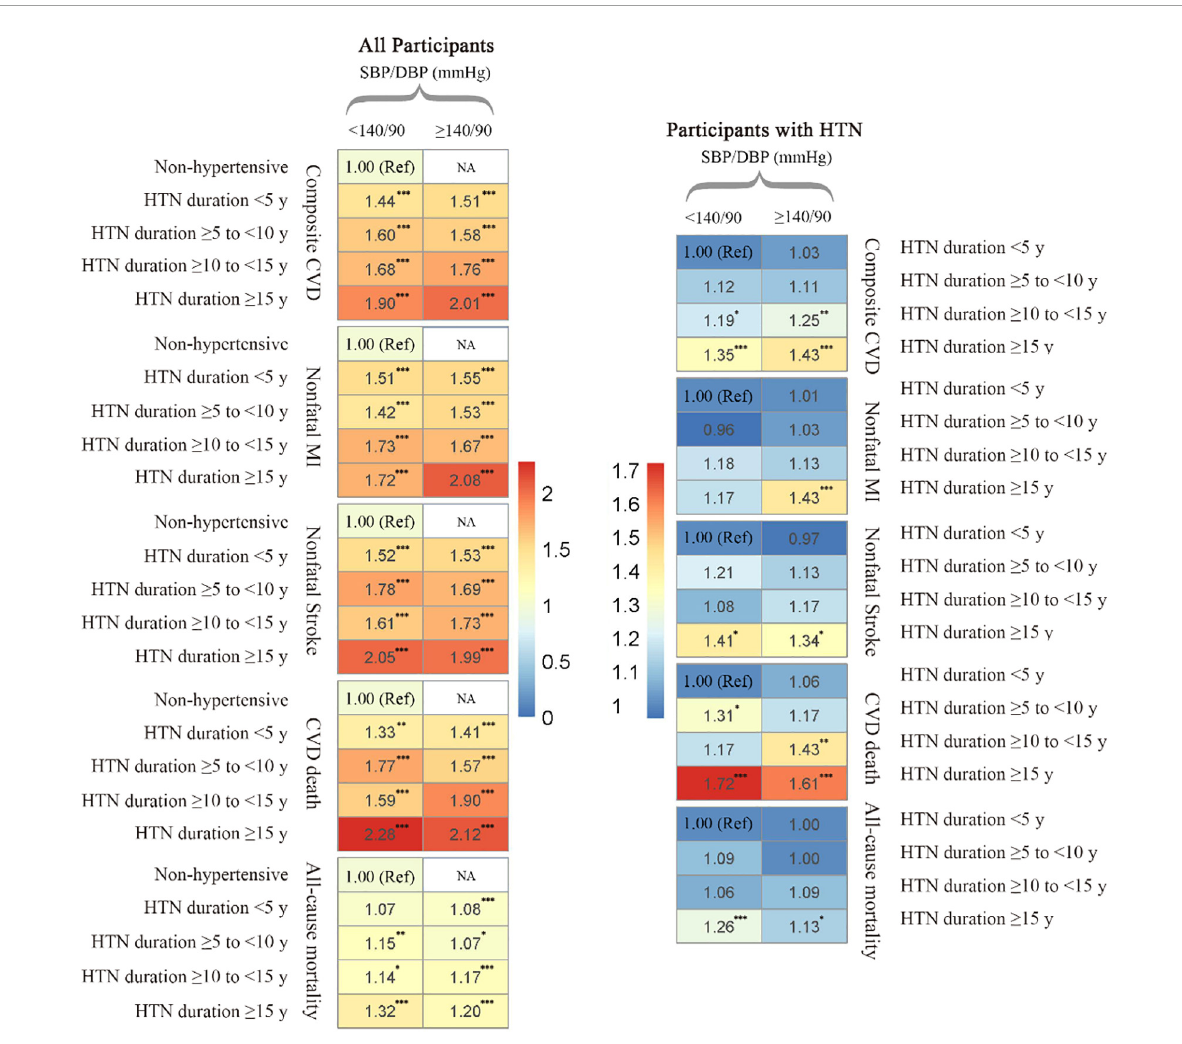
FIGURE2 Cardiovascular disease and all-cause mortality risk matrix for the combined effect of hypotension duration and blood pressure control levels among all participants and participants with hypertension. Risk matrixes were developed using Cox models by blood pressure control levels (SBP/DBP < 140/90 or ≥ 140/90 mmHg). Models were adjusted for age, sex, ethnicity, Townsend score, body mass index, smoking, healthy diet score, diabetes, longstanding illness, hypertensive drug use, and cholesterol-lowering medication use. HTN, hypertension; CVD, cardiovascular disease; SBP, systolic blood pressure; DBP, diastolic blood pressure; MI, myocardial infarction; Ref, reference; NA, not applicable. ∗∗∗ P < 0.001; ∗∗ P < 0.01; ∗ P <